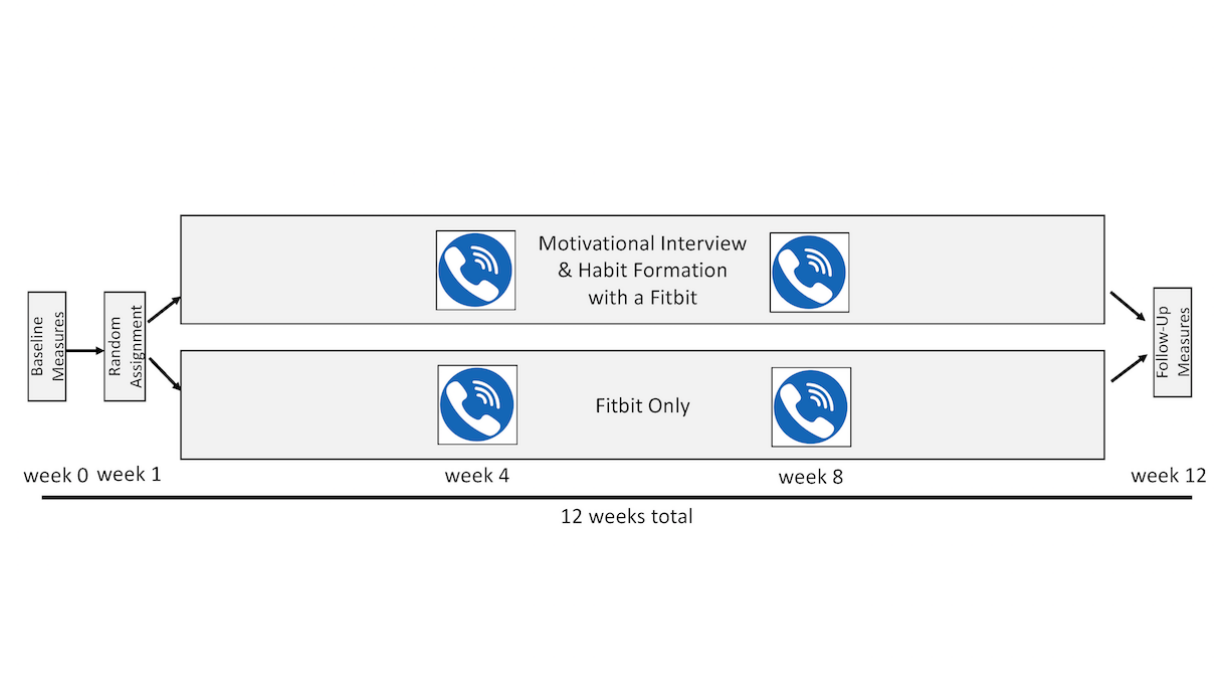
Figure 1. Timeline of study